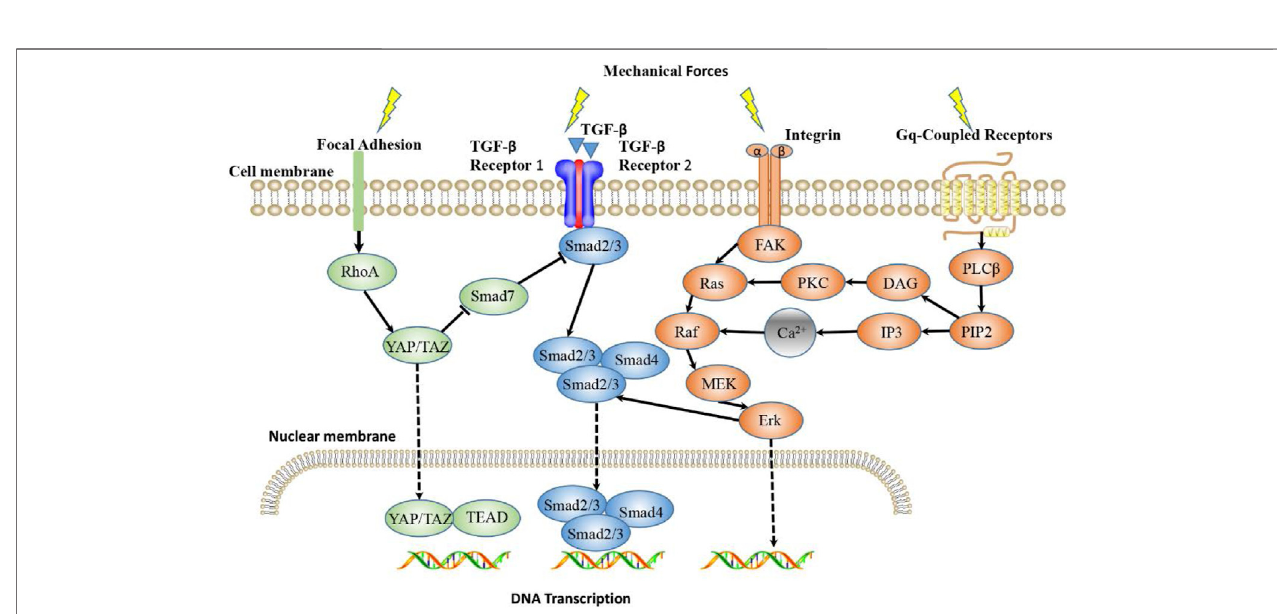
FIGURE 2 | Main Mechanotransduction Signaling Pathways in keloid. TGF- β /Smad, integrin/FAK, YAP/TAZ signaling pathways and Calcium ion signaling are the main mechanotransduction signaling pathways that mediate mechanoresponsiveness. TGF- β senses mechanical forces and signals through Smads, where Smad2/3 binds to Smad4 and enters the nucleus, where they bind DNA and initiate trans-activation of target genes. Integrin signaling induces gene expression through FAK/Erk pathway, and also interferes with TGF- β /Smad signaling pathway. Mechanical stimulation can promote YAP to nuclear transfer and function. The Gq-coupled receptoractivatedbystretchstimulation canactivatePLC β and produceDAGandIP3.IP3actsontheintracellular calciumpooltoreleaseCa 2+ ,resultingintheincrease of intracellular free calcium ion concentration and the subsequent intracellular reaction of Raf/MEK/Erk pathway.